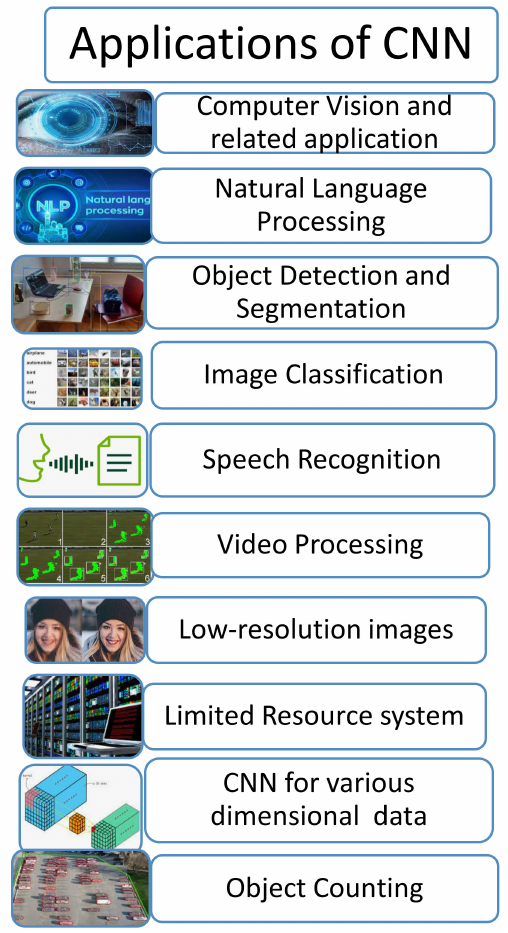
Figure 13. Applications of